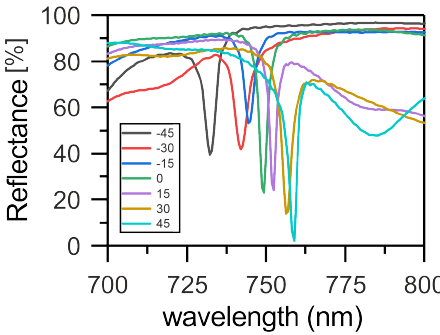
Figure 4. Reflectance spectra of the structure at different angles φ 2 . Positive angles correspond to the clockwise rotation of a nanobrick around the z axis, and negative angles correspond to the counterclockwise